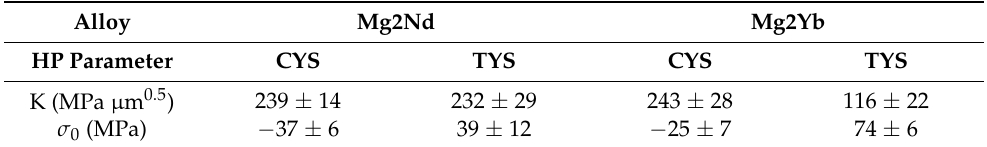
Table 4. Calculated Hall–Petch parameters.